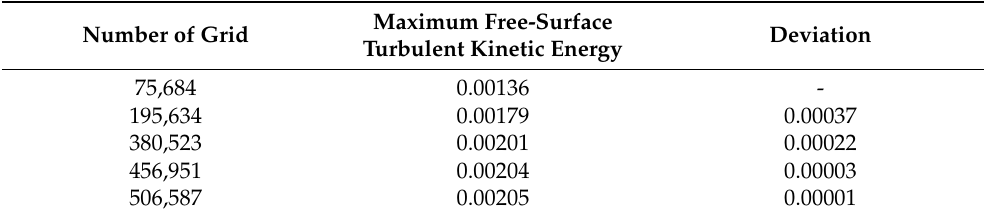
The calculated parameters are shown in Table